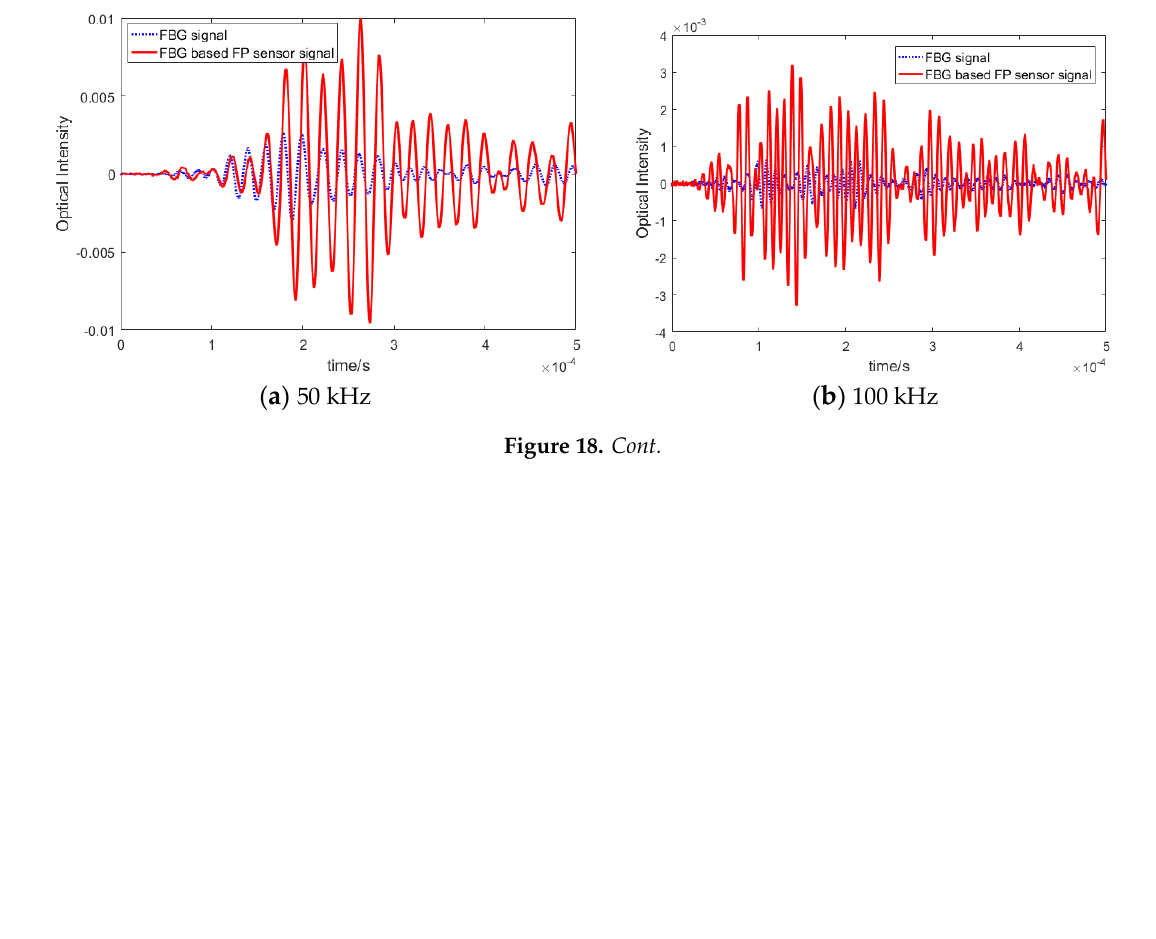
Figure 17. Comparison of damage signals recorded by ( a ), ( c ) FBG-based FP and ( b ), ( d ) FBG sensors.